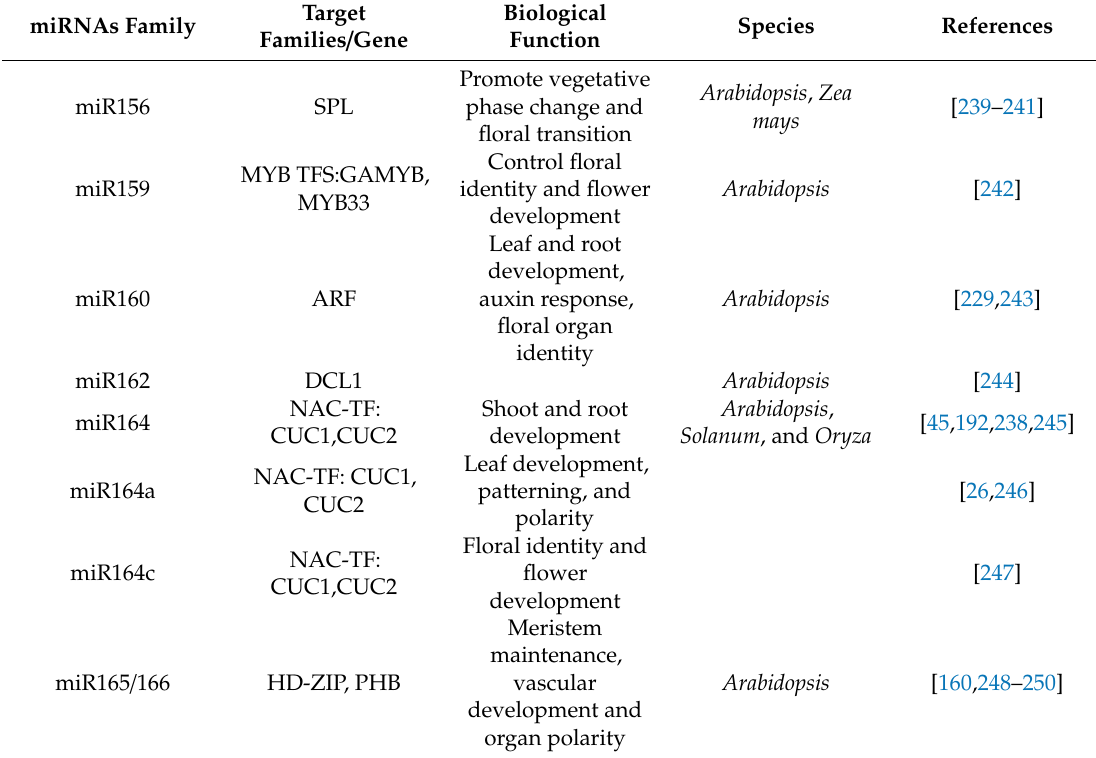
Table 2. MicroRNAs and their predicted targets in Arabidopsis